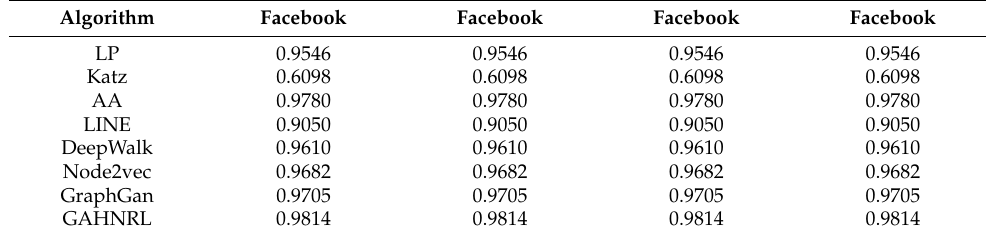
Table 7. Comparison results of different algorithms: AUC.